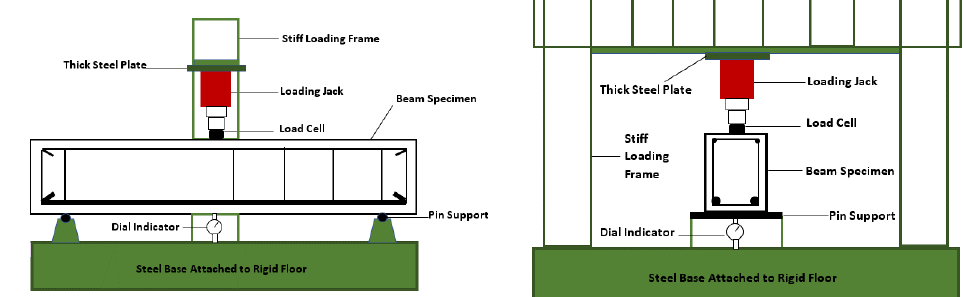
Figure 2. Setting up the beam testing.